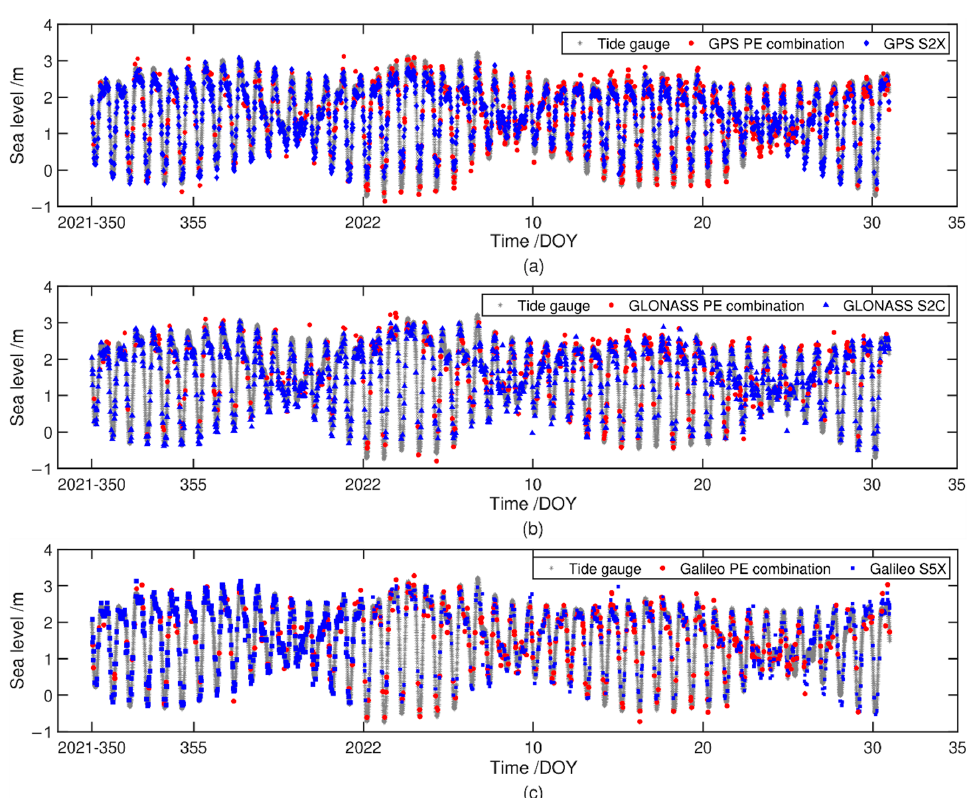
Figure 11. Sea surface height of site SC02 estimated from the PE arcs of multi-GNSS DF carrier-phase observation (red), SNR arcs of the corresponding single-frequency signal (blue), and those measured by the Friday Harbor tide gauge (gray). ( a ) GPS; ( b ) GLONASS; ( c ) Galileo.